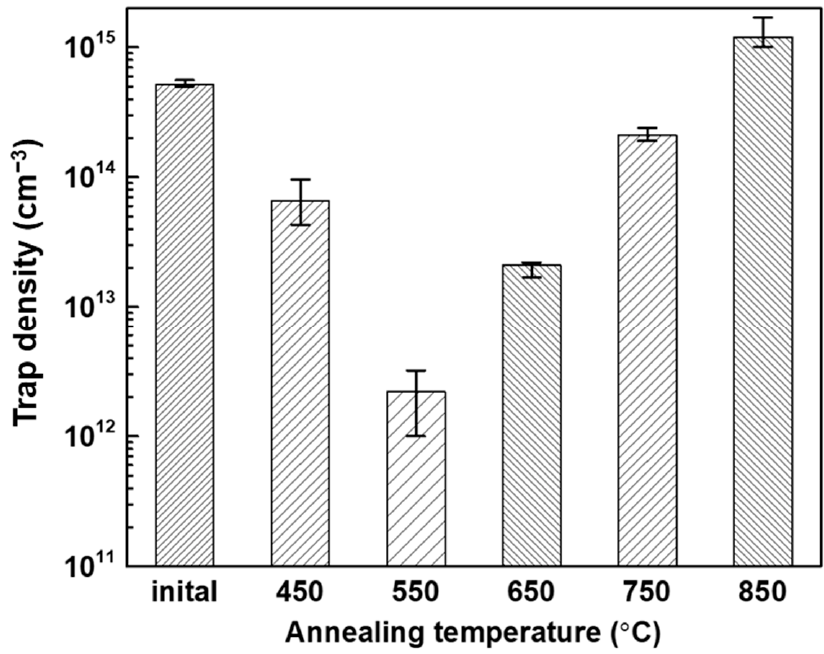
Figure 4. Results of the N trap analysis as a function of annealing temperature.